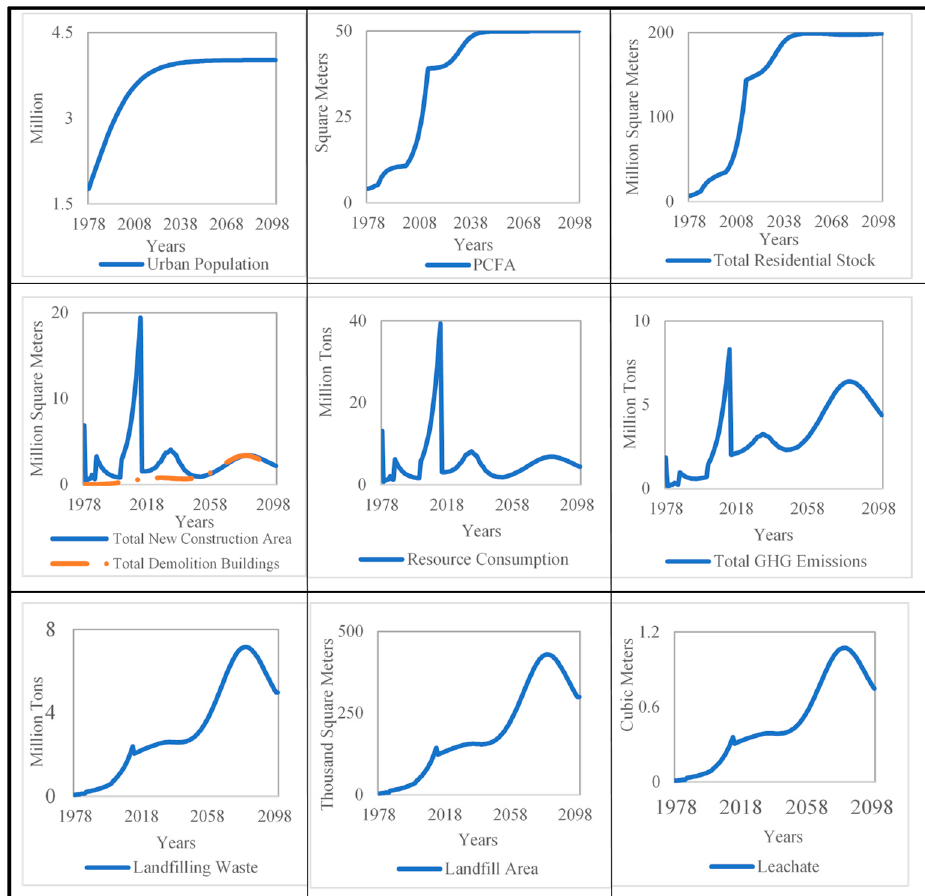
Figure 3. Simulation results of urban residential building stock of Jinan from 1978 to 2100.